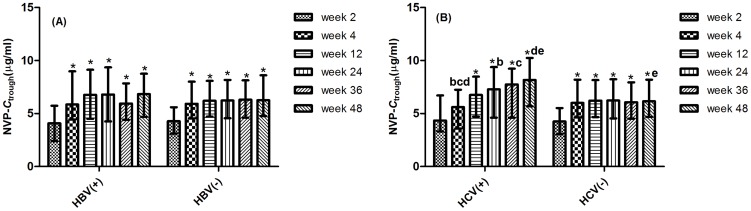
Relationship between nevirapine trough concentration and underlying liver diseases.The differences for nevirapine trough concentration between lead-in and steady-state periods was observed in patients with HBV infection (A). The nevirapine trough concentration at week 4 was significantly lower than the values at week 24, 36 and 48 (P<0.05) in patients with HCV infection (B). The nevirapine trough concentration at week 48 in patients with HCV infection was significant higher than those without HCV coinfection (P = 0.004).